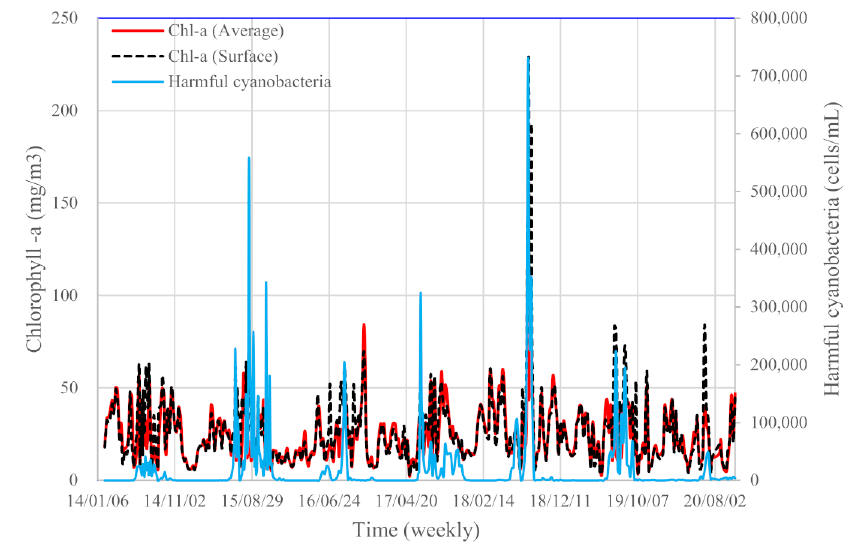
Figure A2. Comparison of harmful cyanobacteria and chlorophyll-a observed in the Changnyeong-Haman Weir.